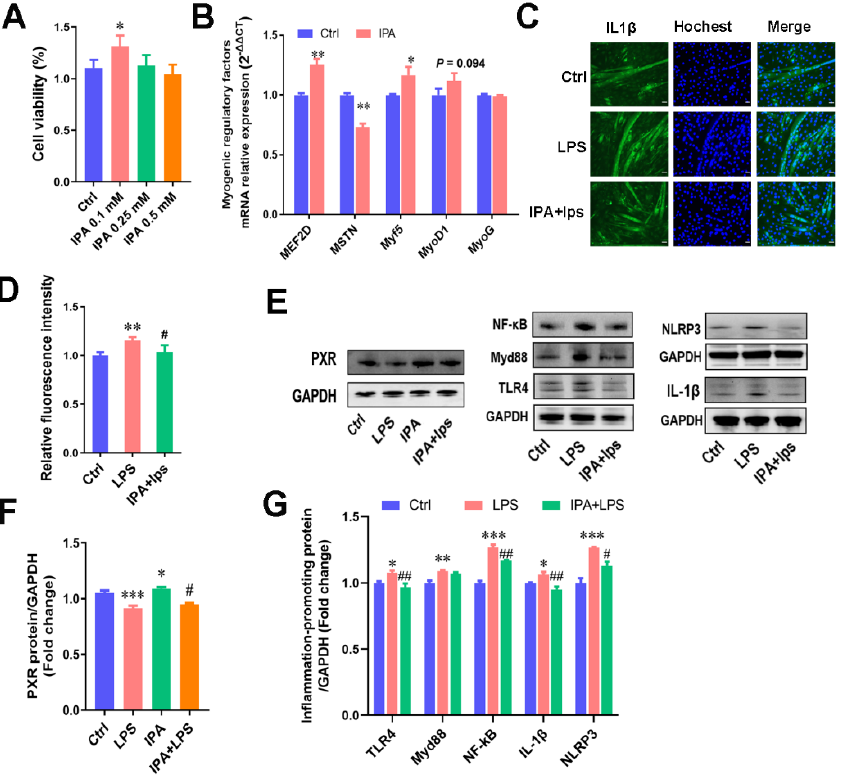
Figure 3. IPA promoted cells’ proliferation and alleviated inflammation responses in C2C12 cells.